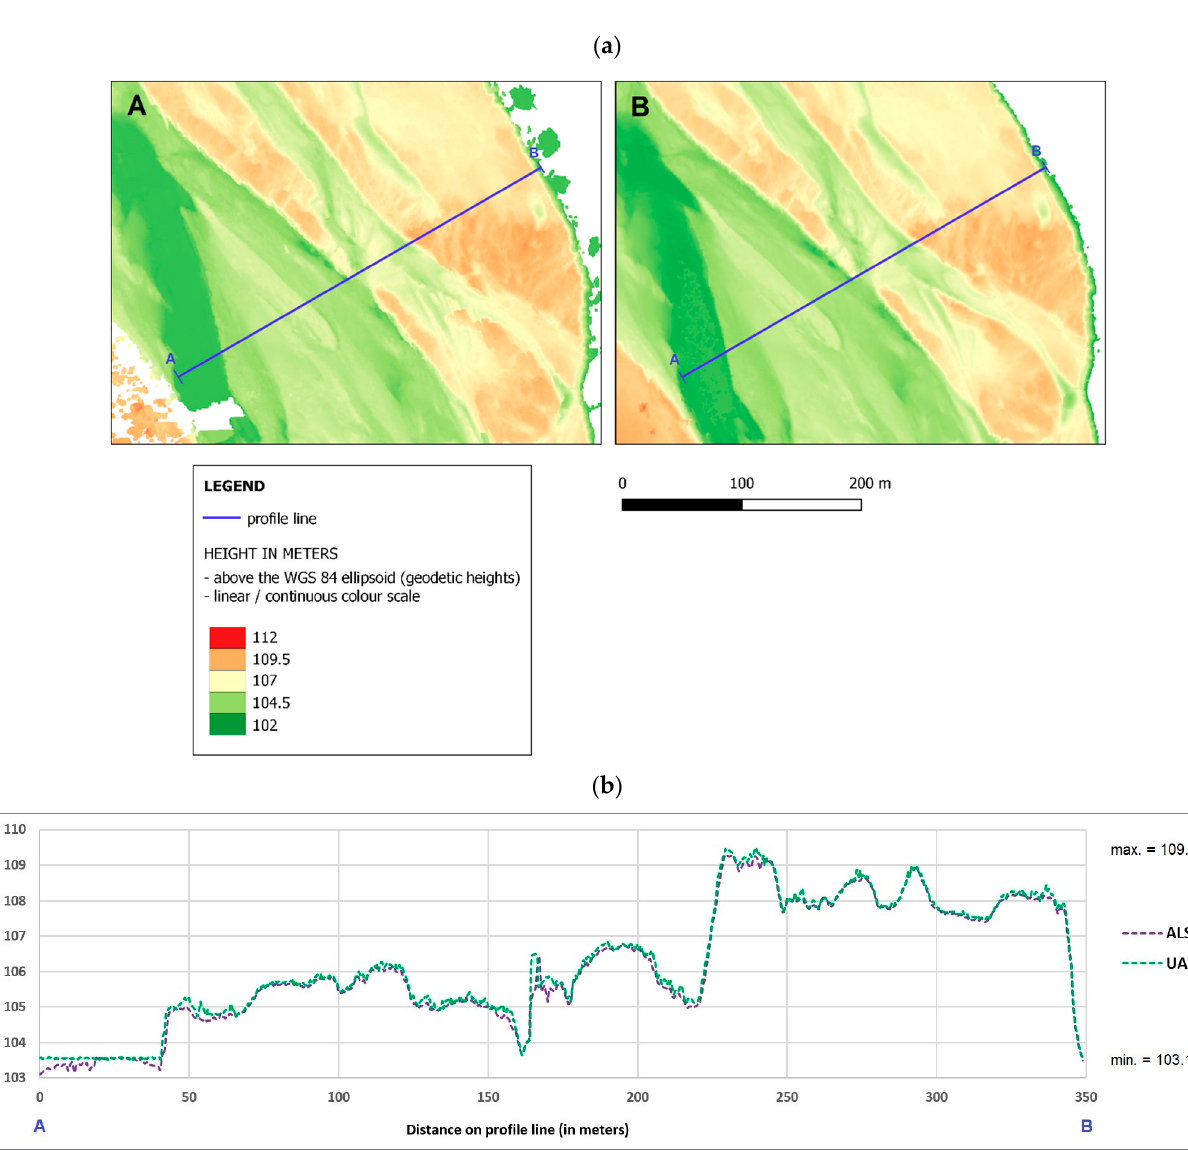
Figure 14. ( a ) Southern Island cross-section used to make the profile graph, image A —ALS, image B —UAV-LS, ( b ) Southern Island—profile lines comparing two LIDAR-based digital terrain models (DTMs). The measurement values are in metres, WGS84 ellipsoidal (geodetic heights).